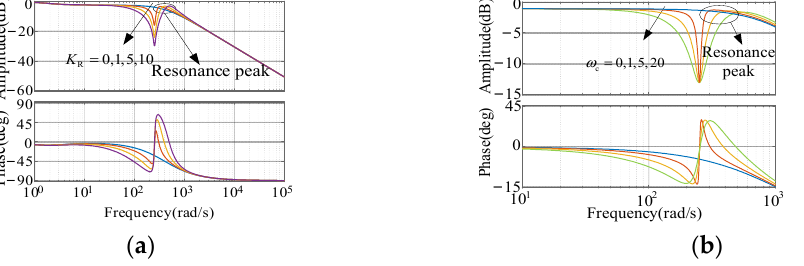
Figure 7. Frequency response of RSC F 1 ( s ) based on resonant control. Table 1. DFIG experimental platform-related parameters.